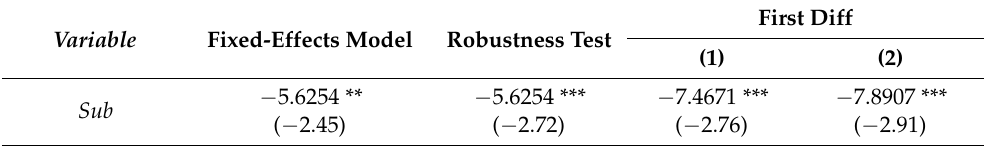
Table 4. Regression results of different